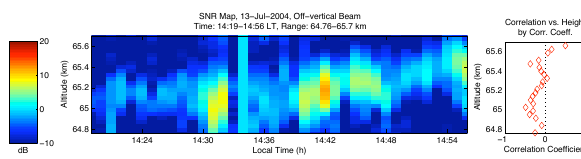
Fig. 17. Segments of meridional wind maps for May 27, 2003, (a and b) and May 28 (c). Fig. 16. A thin sheet at 66.2km on 13 July at 14:10 LT.